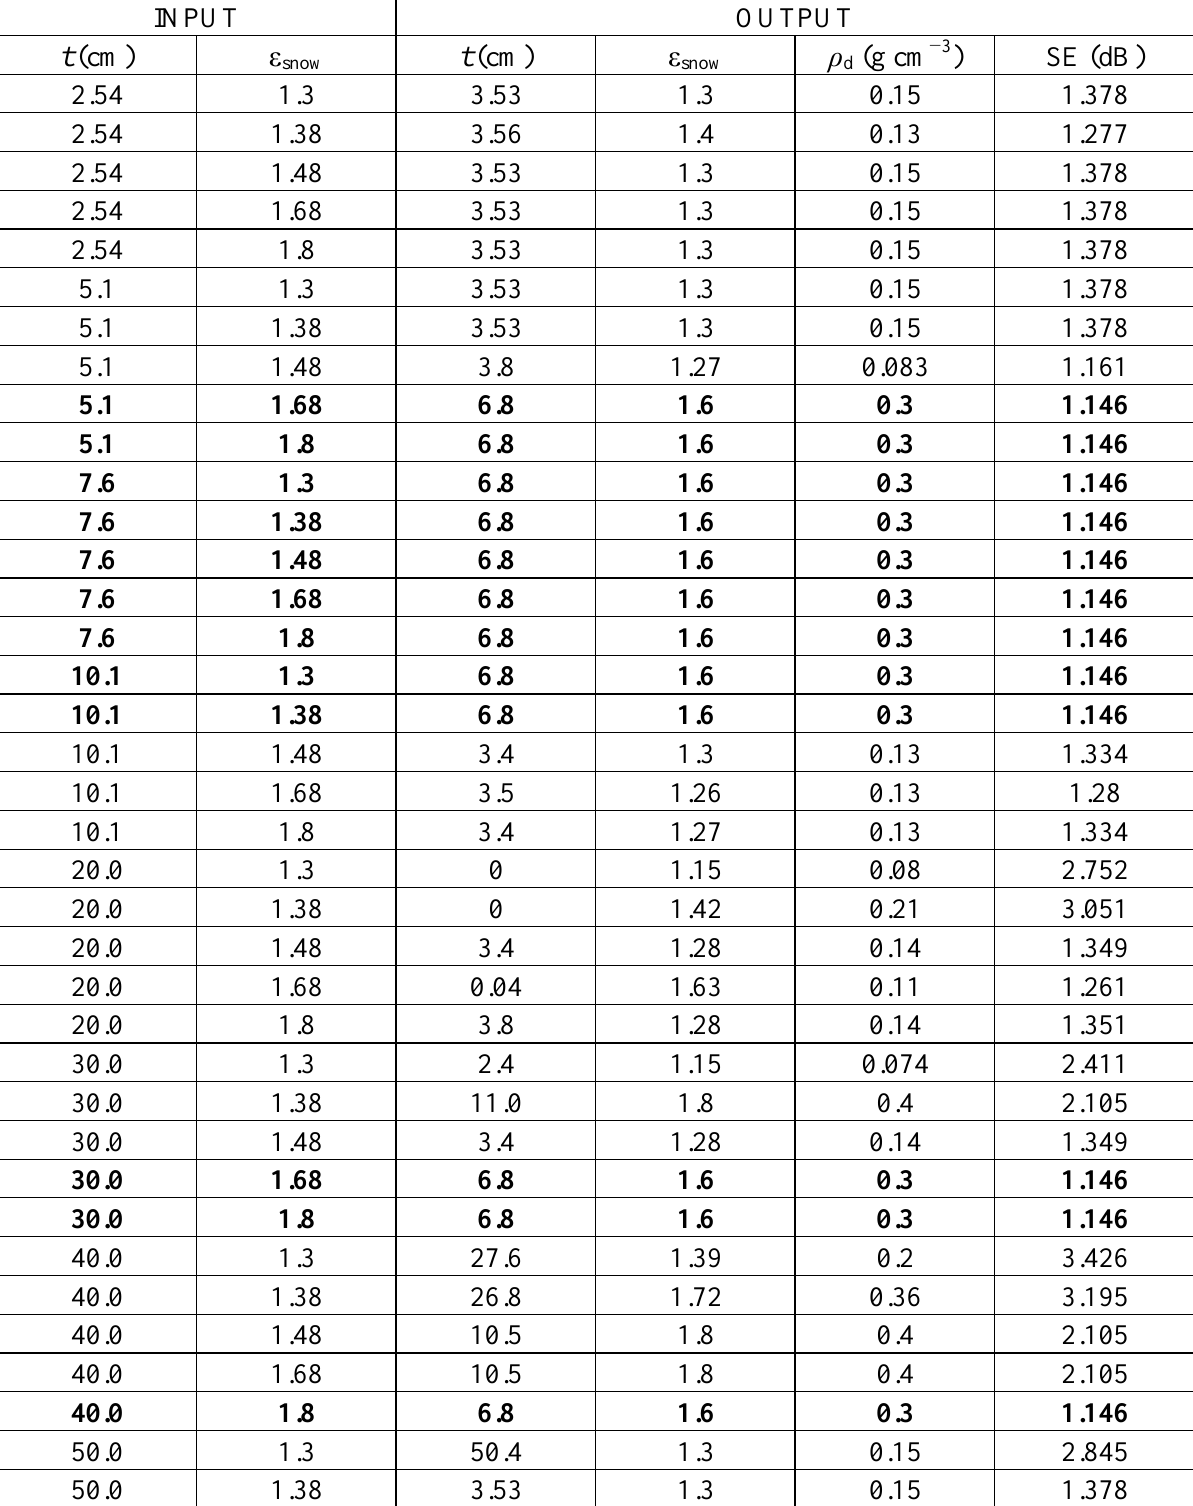
Table 2. Summary of the output values of snow depth ( t ), snow permittivity (ε density ( ρ ) and standard error (SE) produced by 45 paired input combinations of snow d depth and permittivity using a quasi-Newton algorithm (QNA). The bold entries indicate the smallest SE result of 1.146, which corresponds to output values of snow depth and snow density of 6.8 cm and 0.3 g cm −3 ,